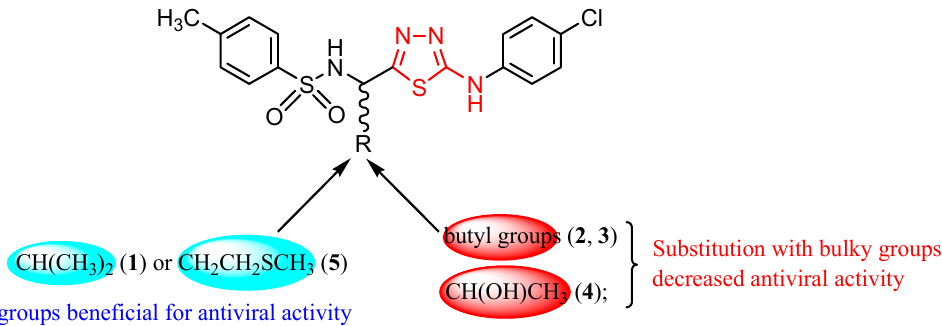
Figure 1. Influence of substituents of 1,3,4-thiadiazole derivatives 1 – 5 on anti-HIV activity.